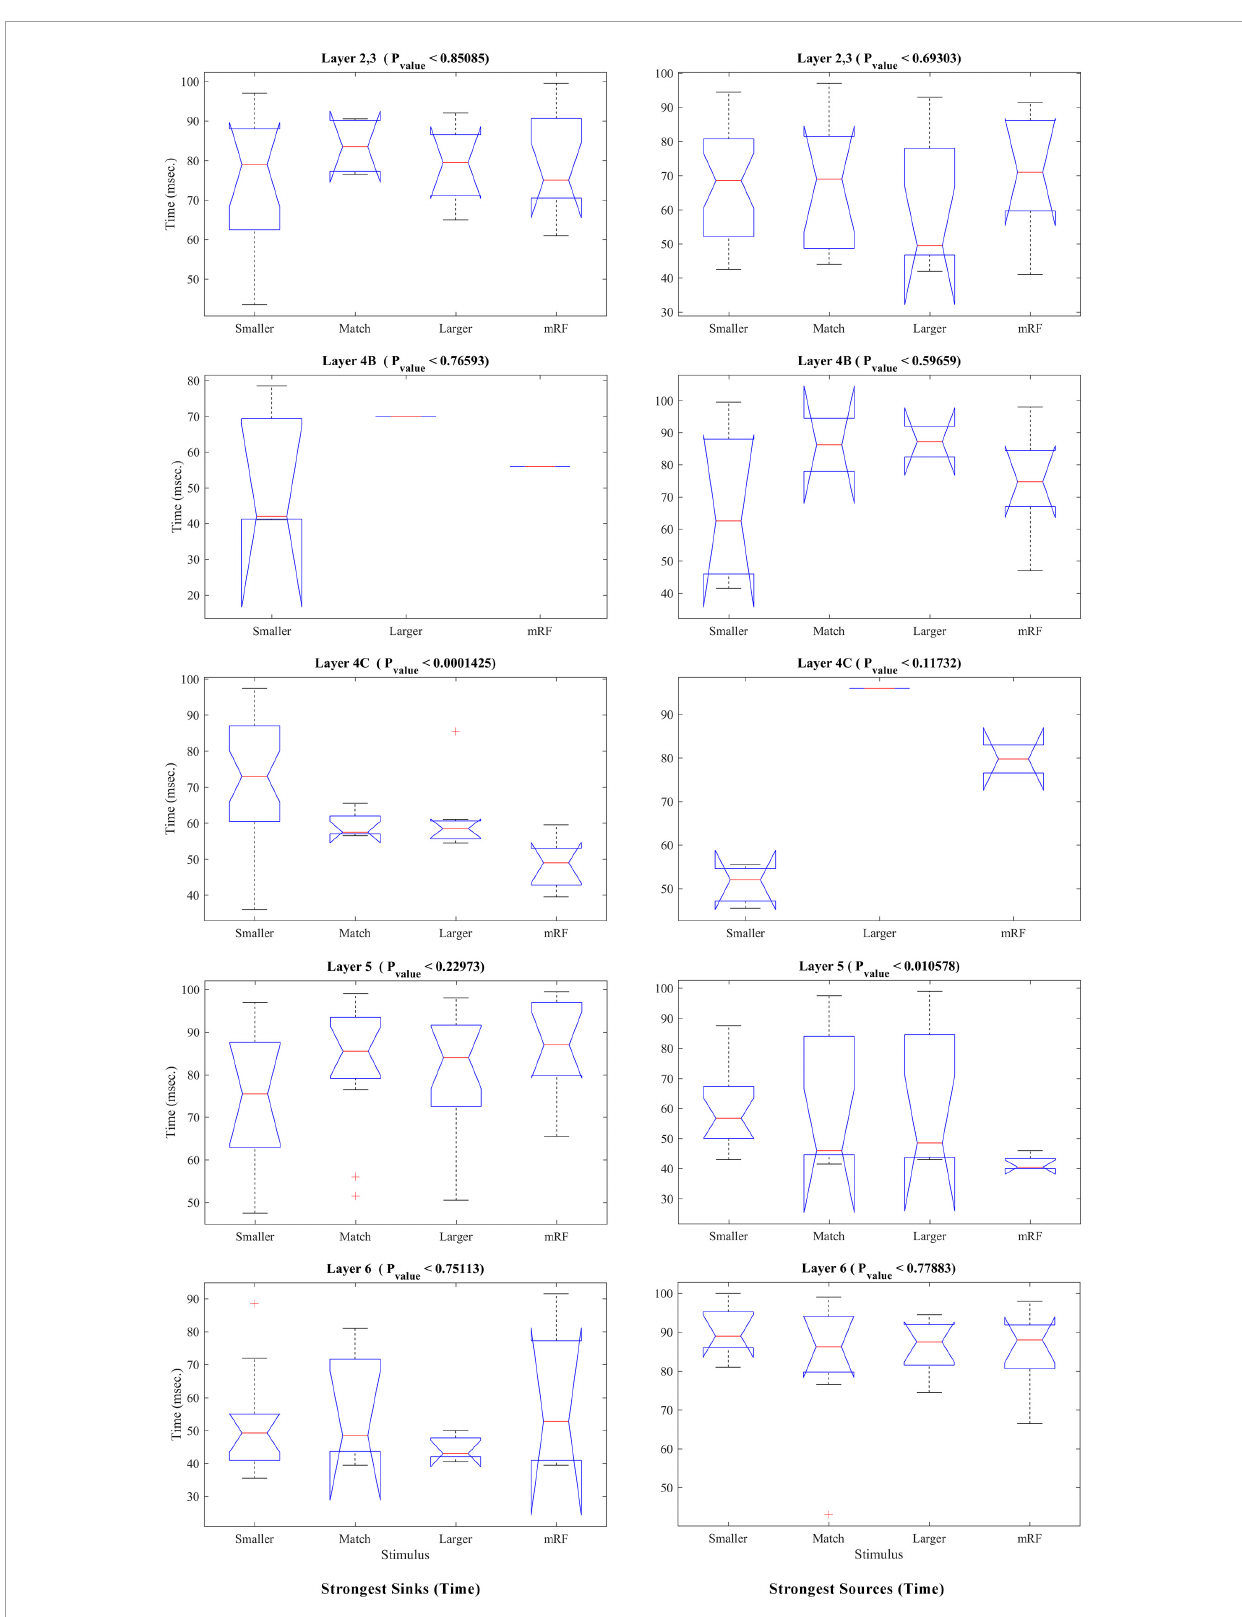
FIGURE8 The statistical test for comparing different stimulus conditions in each layer. The Kruskal–Wallis test, which is performed in Figure 6 , is analyzed in this figure with the approach of layer separation and comparison of stimulus types. The result of the statistical test of the time of the strongest sinks is shown in the (left column) and the time of the strongest sources is shown in the (right column) . The type of stimulus is specified on the X-axis. The Y-axis represents the time in milliseconds. At the top of each figure, the layer number and P -value are